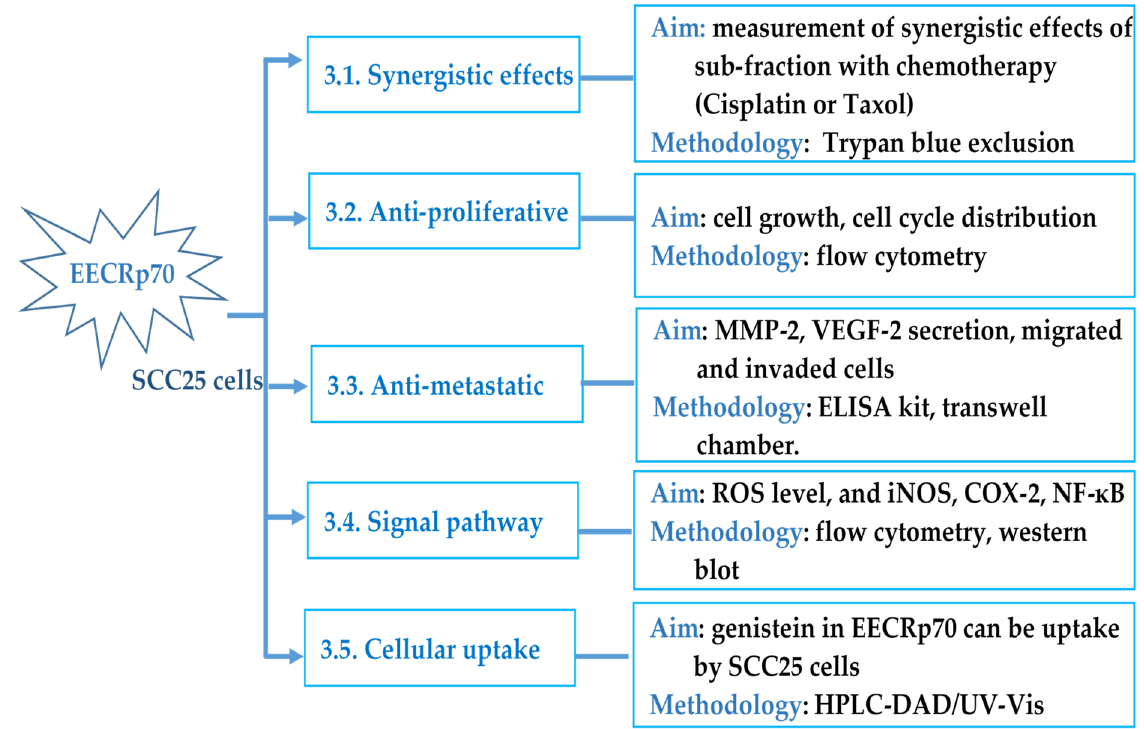
Figure 1. Flowchart of the best sub-fractions of the 95% ethanol extract from the roots of C. cajan (L.) Millsp. (EECR95) on anti-proliferative and anti-metastatic effects on oral squamous cell carcinoma (SCC25 cells).